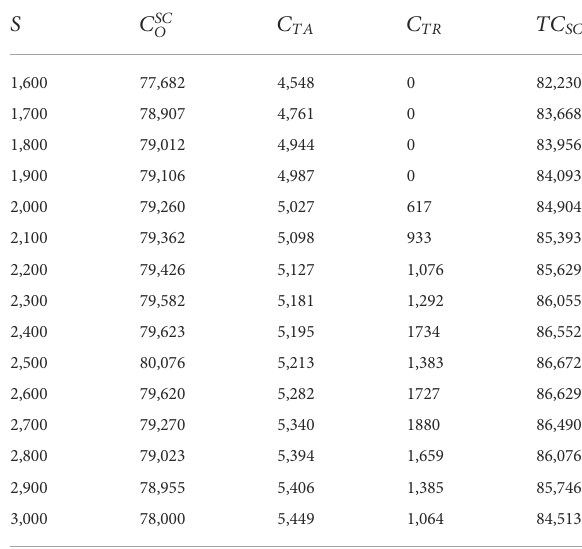
and carbon trading. S C SC C O